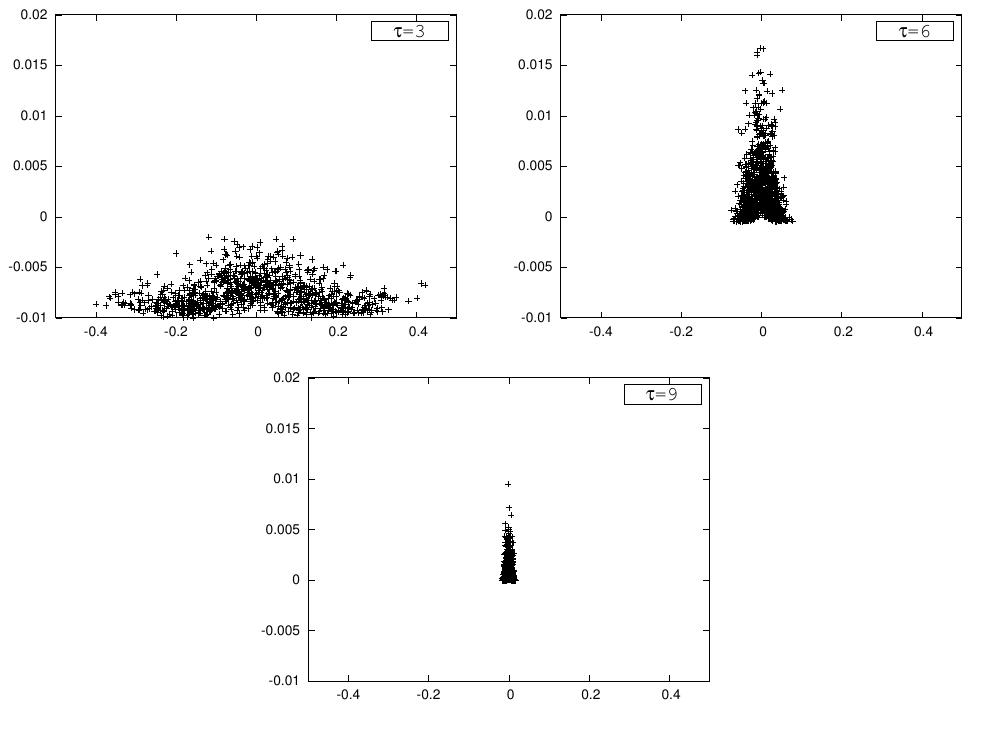
-0.05-0.04-0.03-0.02-0.01